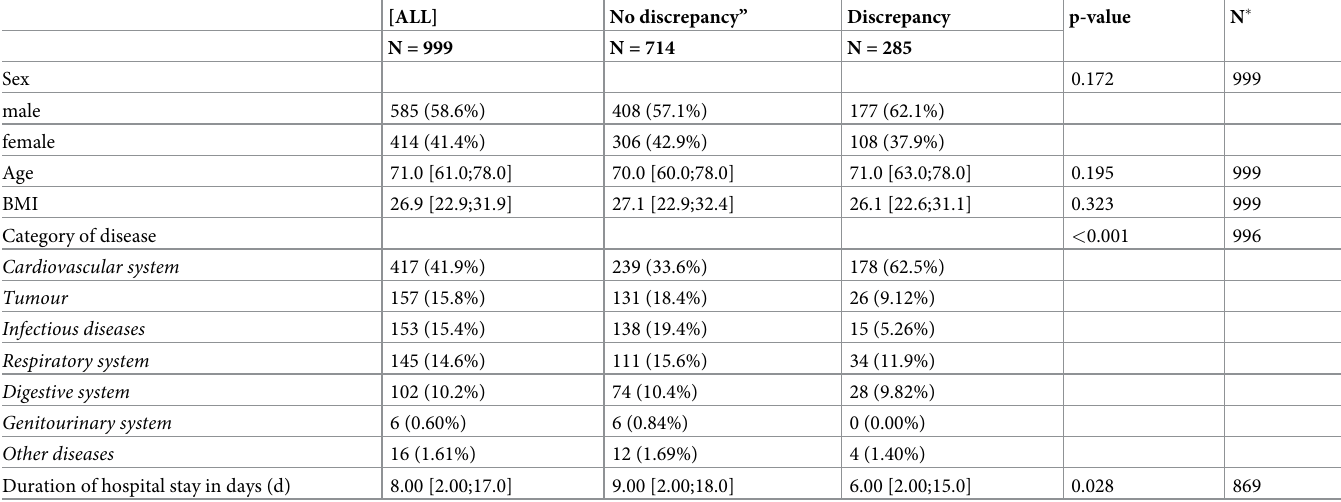
Table 2. Groups of discrepancy without the group of new-borns.